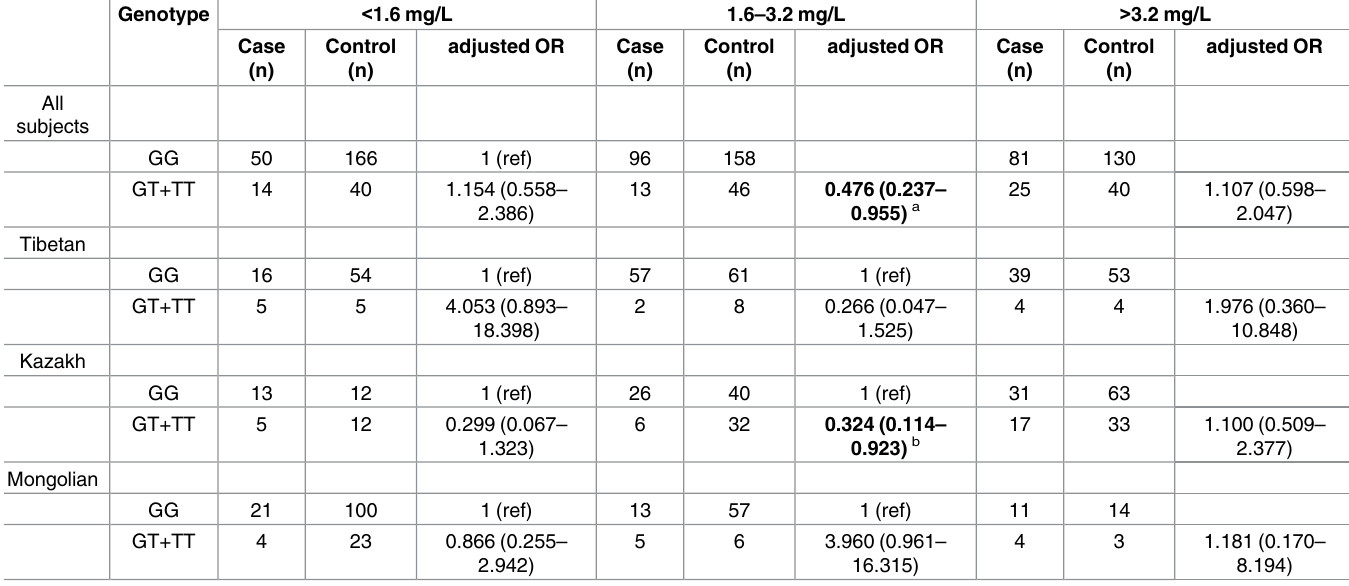
Table 7. Associations between skeletal fluorosis and the PRL rs1341239 genotype in different UF groups (overall or stratified by ethnicity).